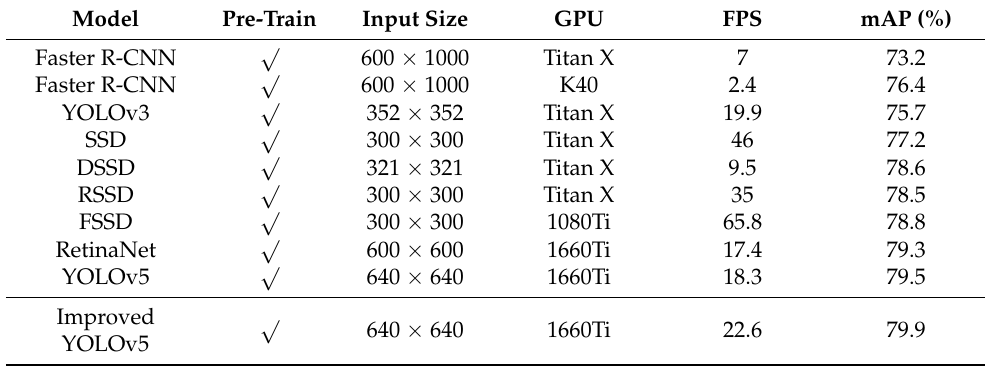
Table 2. Comparison of the test detection results on the PASCAL VOC 2007.